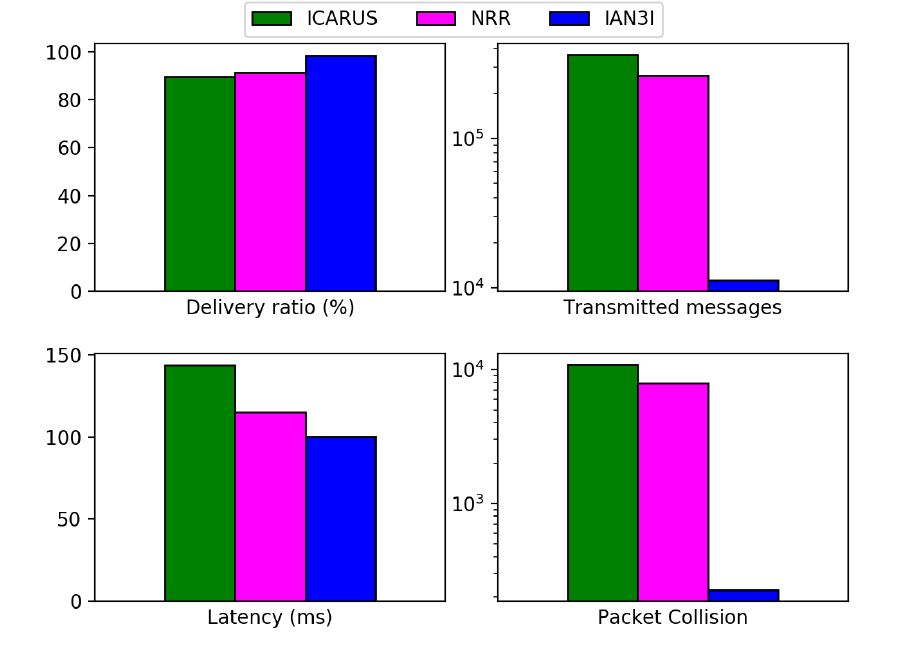
Figure 5. Results of network evaluation metrics for ICARUS, NRR and IAN3I when dealing with unexpected traffic